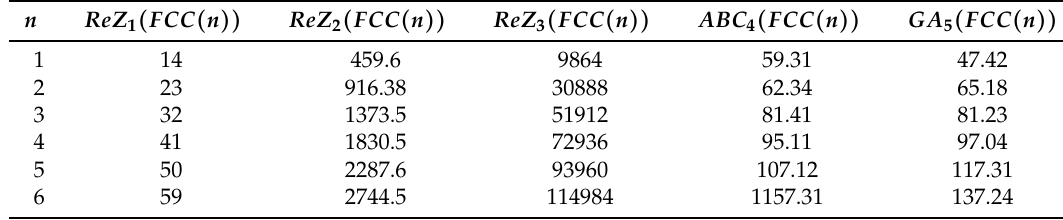
Table 4. Comparison of all indices for face-centered cubic lattice FCC ( n )